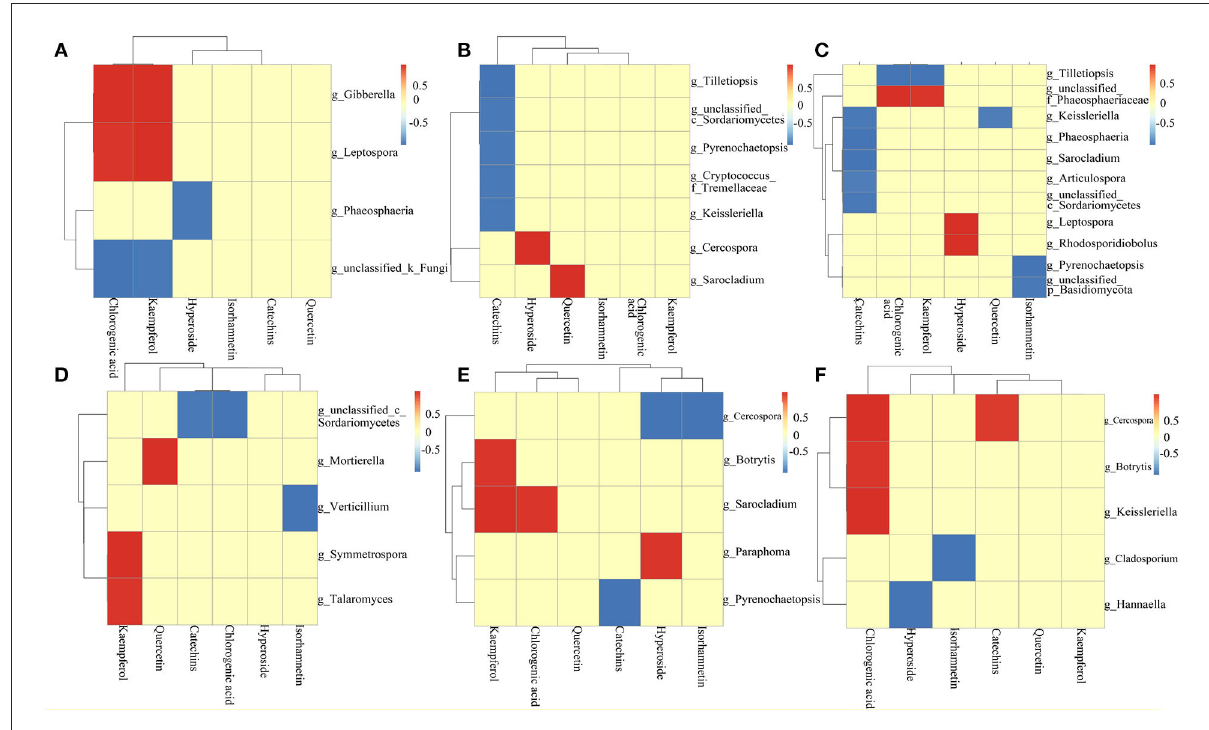
FIGURE10 Analysis of the correlation between core community and active ingredient [ (A) ZP root; (B) ZP stem; (C) ZP leaf; (D) WP root; (E) WP stem; (F) WP